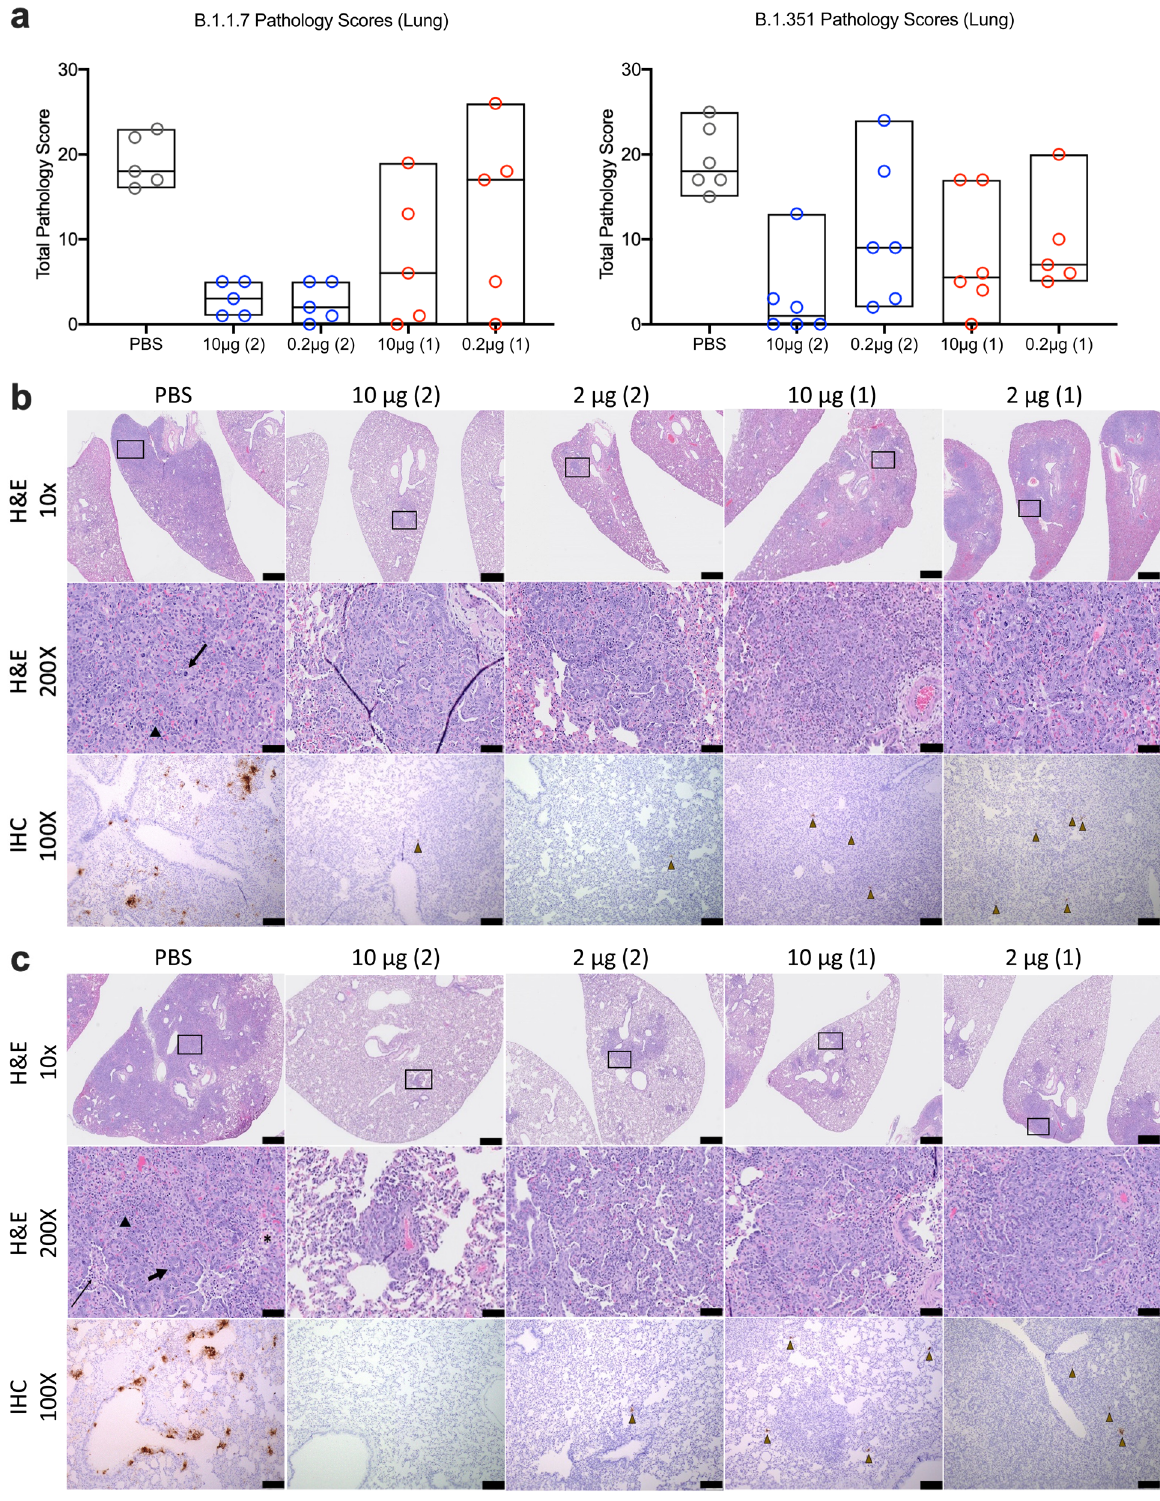
by VOC to include B.1.351, particularly using a 2-dose regimen. Following the challenge phase of the study, assessment of viral loads by TCID50 in lung tissues and nasal turbinate demonstrated clear protection from challenge with either B.1.1.7 or B.1.351,